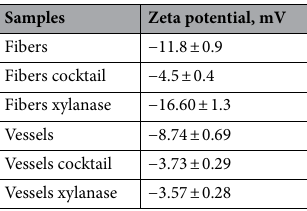
Table 4. Zeta potential (Zetasizer) for fibers and vessels, treated and untreated.